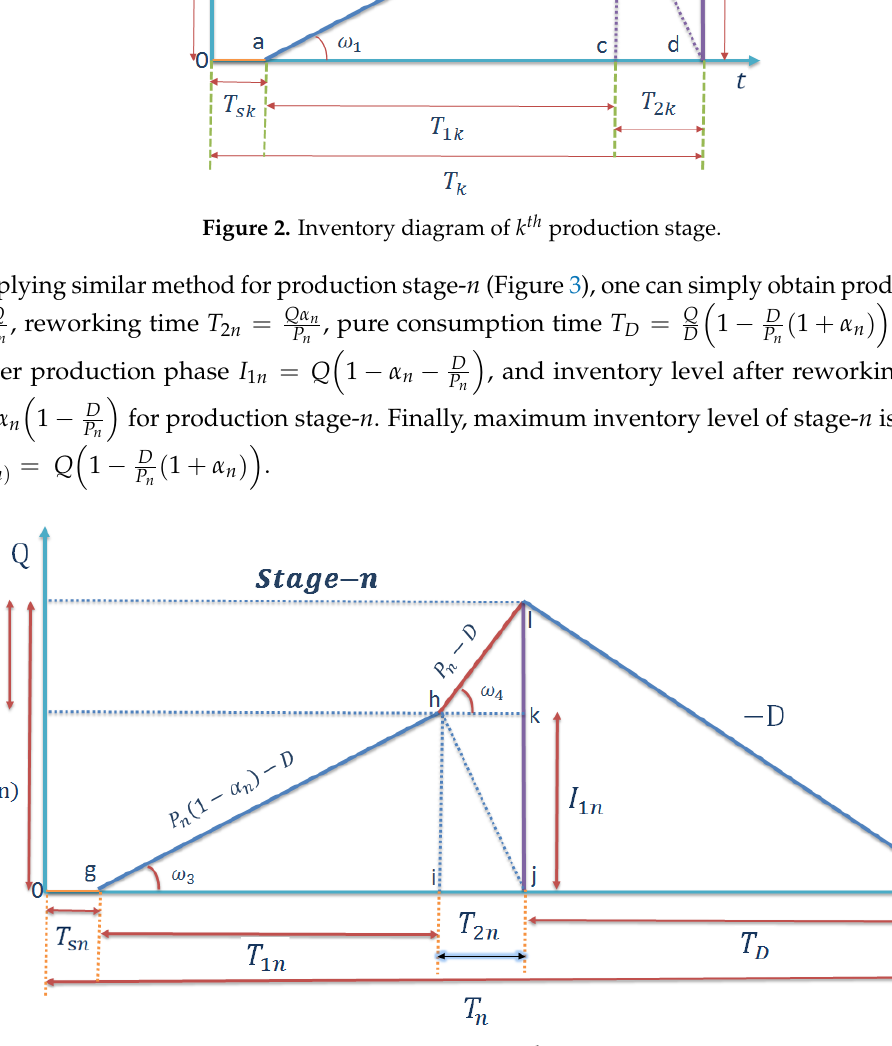
Figure 3. Inventory diagram of n th production stage.